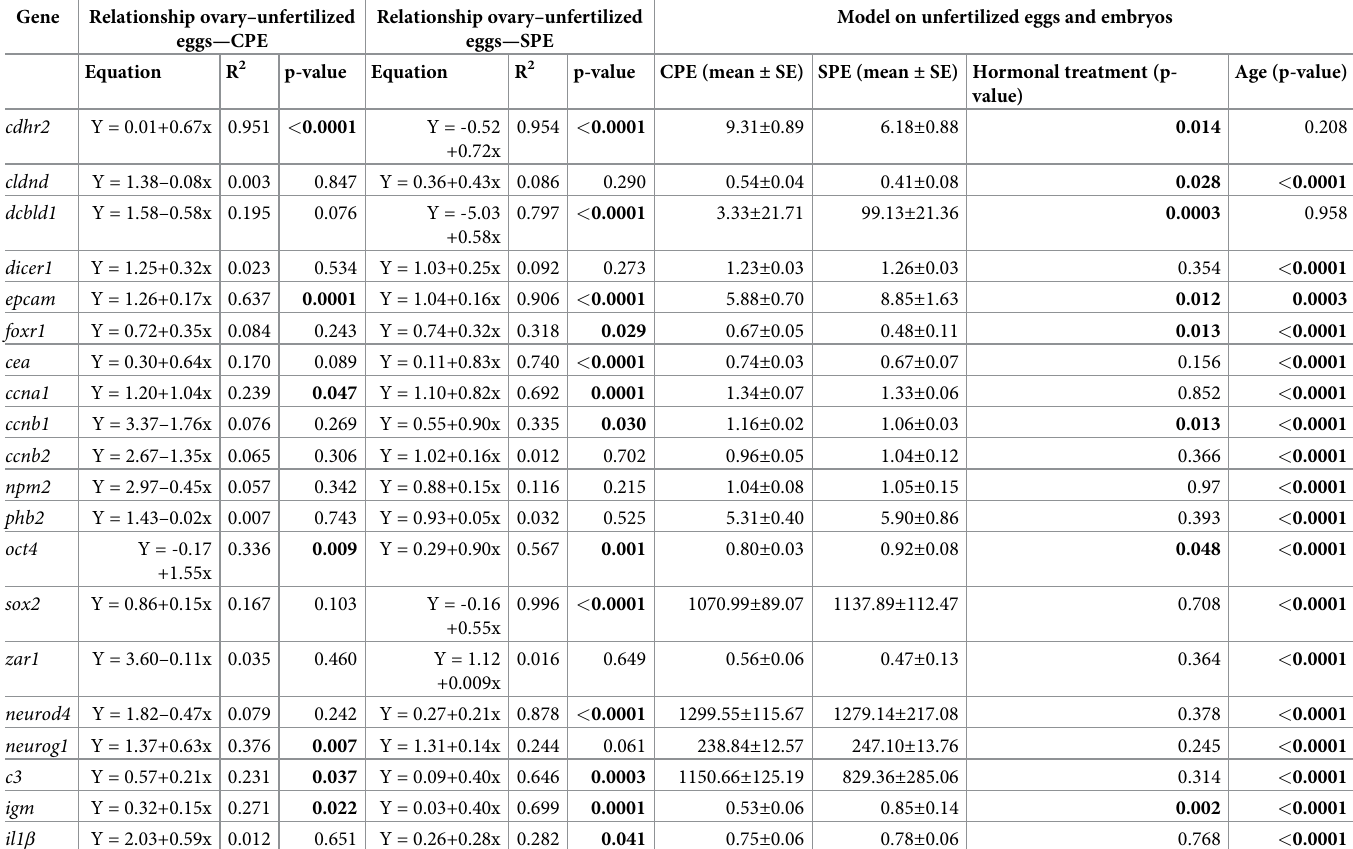
Table 3. Gene expression in ovary, unfertilized eggs, and embryos in two successive trials with hormone-treated European eel, Anguilla anguilla . Best fitting rela- tionship between expression of the gene in the ovary of female and levels of mRNA transcripts in unfertilized egg for each treatment and mRNA abundance from unfertil- ized egg to embryos (shortly before hatch) related to hormonal treatment (CPE and SPE) and age of embryos (in